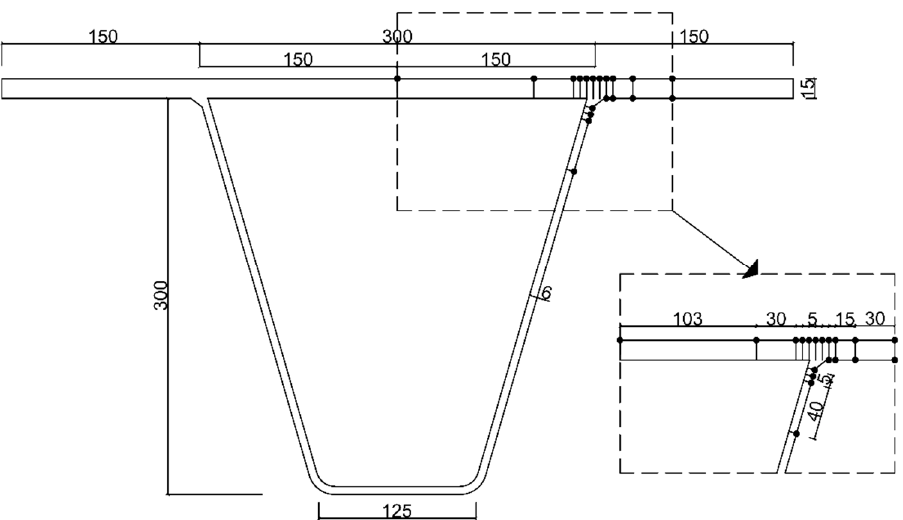
Figure 11. Locations of measured strain gauge rosettes (dimensions in mm).